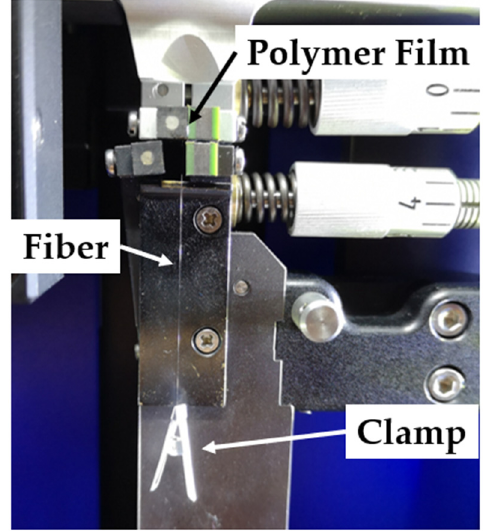
Figure 4. Setting up a fiber extract sample in the Favimat+.